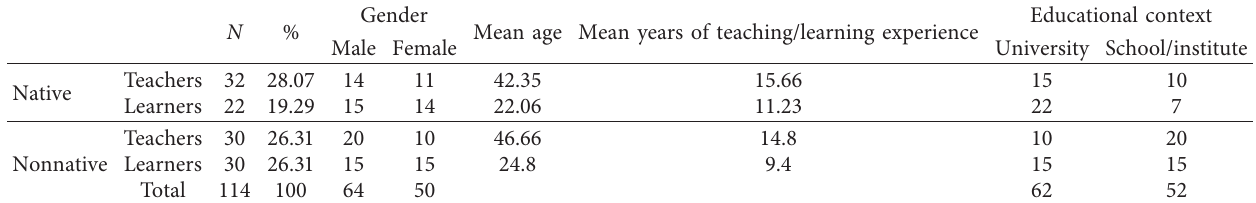
Table 3: Demographic characteristics of